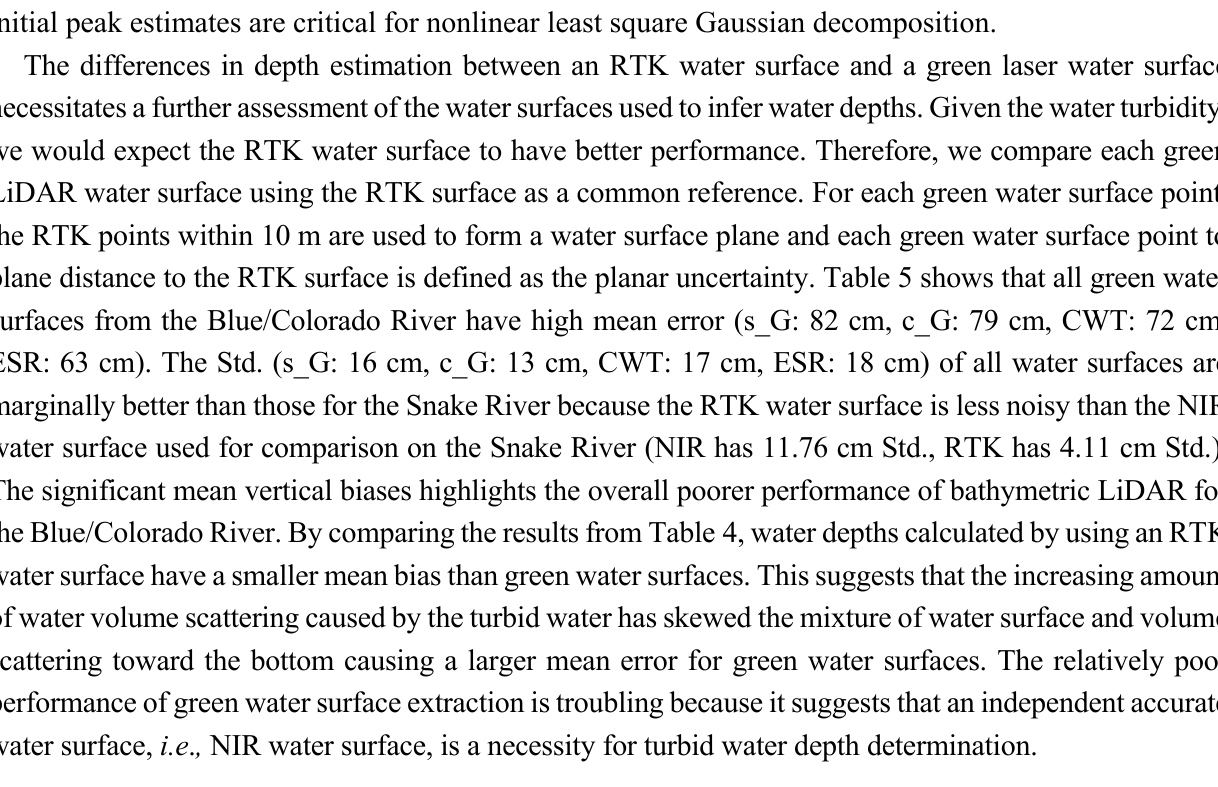
Table 5. Statistical mean vertical error and Std. for different green water surfaces.